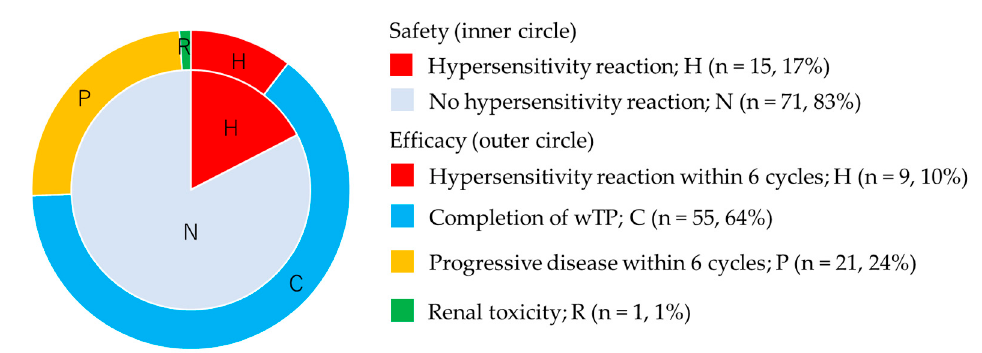
Figure 2. Safety and long-term efficacy of weekly paclitaxel and cisplatin. Inner circle shows safety and outer circle shows long-term efficacy.